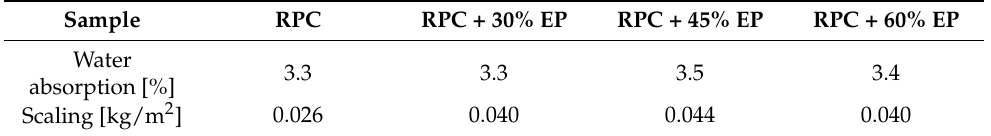
Table 5. Water absorption and scaling during freeze-thaw test of lightweight RPC.